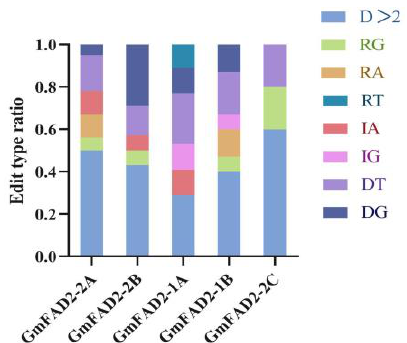
Figure 9. Proportion of different editing modes in different editing carriers.